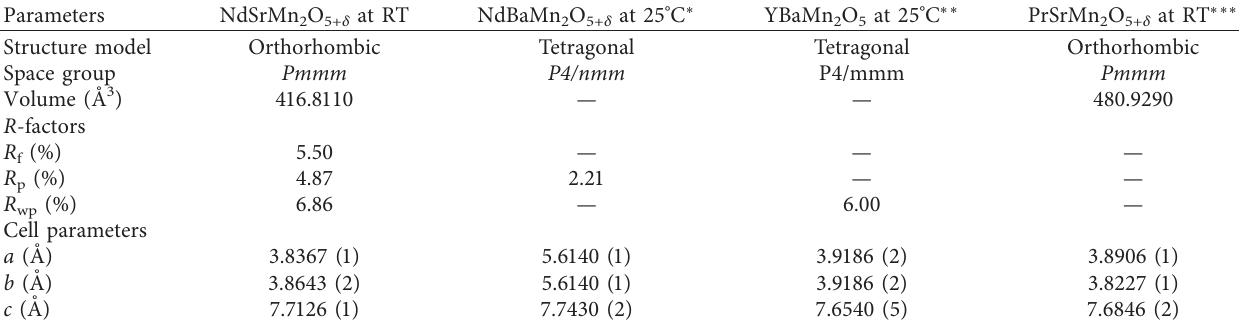
Table 1: Comparison of the results obtained from the Rietveld analysis of NPD data for NdSrMn other data from the